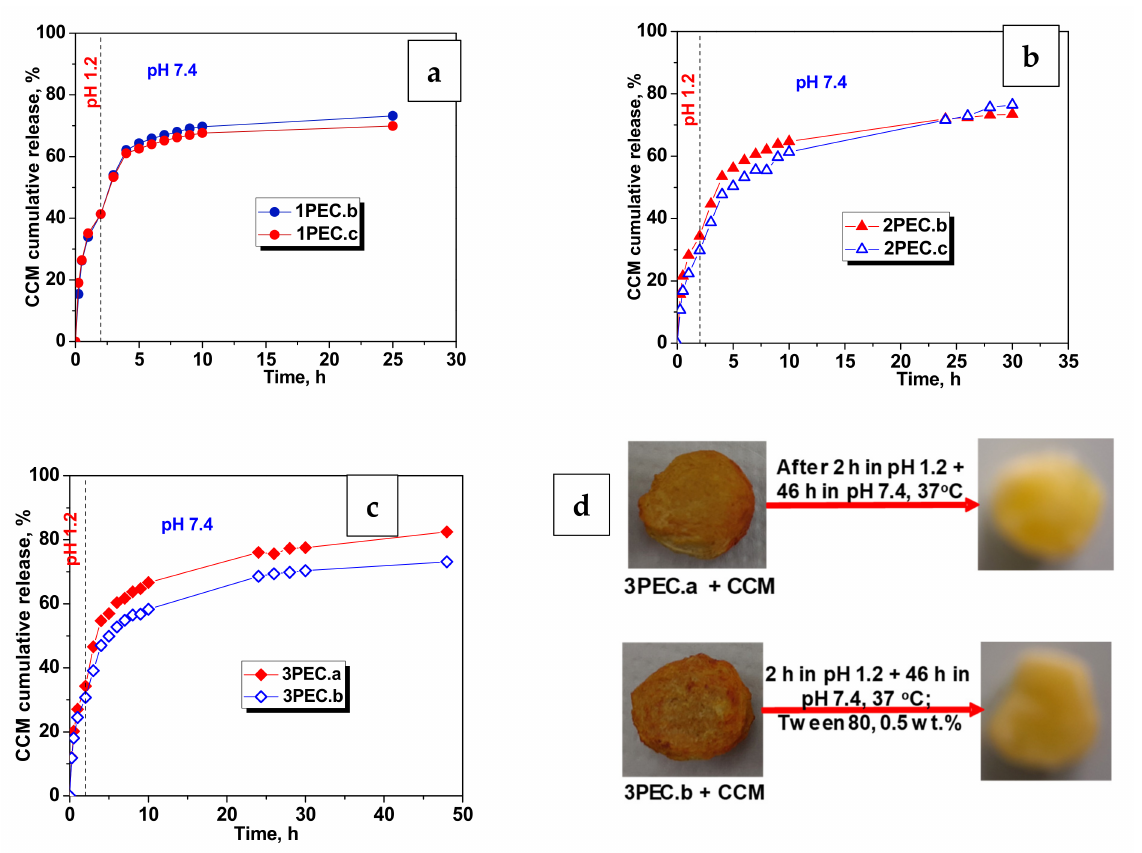
Figure 8. ( a – c ) CCM release kinetics in aqueous solution of Tween 80, 0.5 wt.%, at 37 ◦ C; ( d ) optical images of PECs loaded with CCM and after partial release of